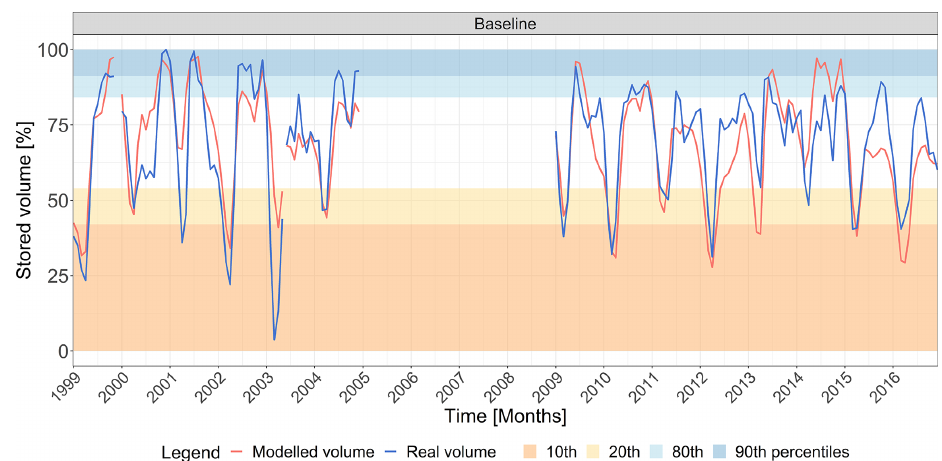
Figure 4. S. Giustina stored volume values from 1999 to 2016. Modelled (red line) and real (blue line) values. Adjusted R 2 = 0.60, RMSE = 19.74Mm 3 . Coloured bands outline areas of values lower than the 10th and 20th and greater than the 80th and 90th percentiles. For an interpretation of the references to colour in this figure legend, the reader is referred to the web version of this article. Table 4. Average values of temperature and precipitation (COSMO-CLM projections), water inflow to the S. Giustina reservoir, turbined outflow, stored volume (simulations) and their percentage differences compared to baseline values. Variable Baseline RCP4.5